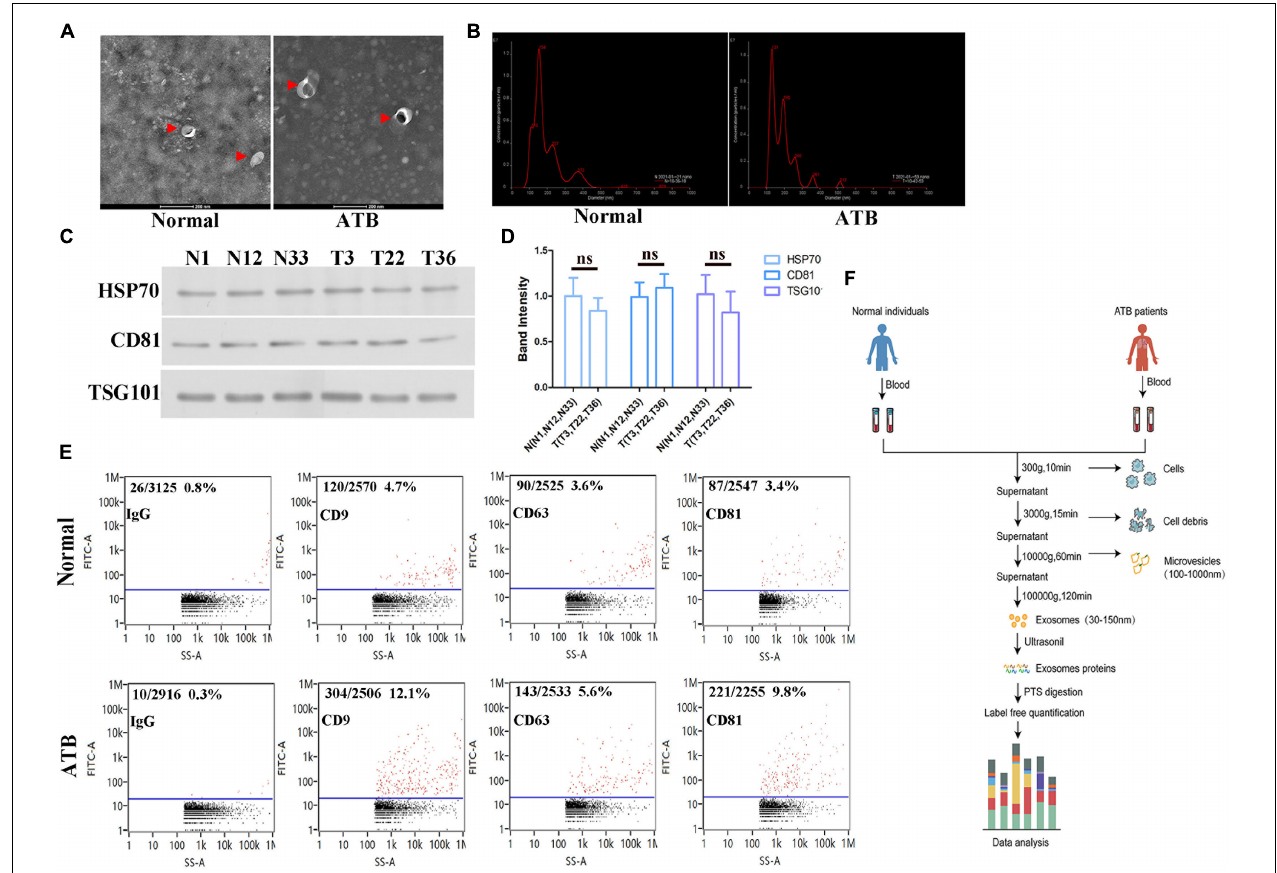
FIGURE 1 | Biological characterization of exosomes isolated from serum. (A) Transmission electron micrographs of isolated exosomes from the serum of normal individuals and patients with ATB. Representative image of exosomes at a magnification of × 200. (B) Size distribution of exosomes was determined by using NTA. Particle size (150 nm) and concentrations (2.01E10 particles/mL). (C,D) HSP70 and CD81 in exosomes from normal individuals (N#1, N#12, and N #33) and patients with ATB (T#3, T#22, and T #36) were quantified via western blotting. TSG1-101 was used as a control. (E) Exosomal marker proteins CD9, CD63, and CD81 on exosomes were detected by using flow cytometry. (F) Schematic diagram of separation and proteomic analysis of serum exosomes.